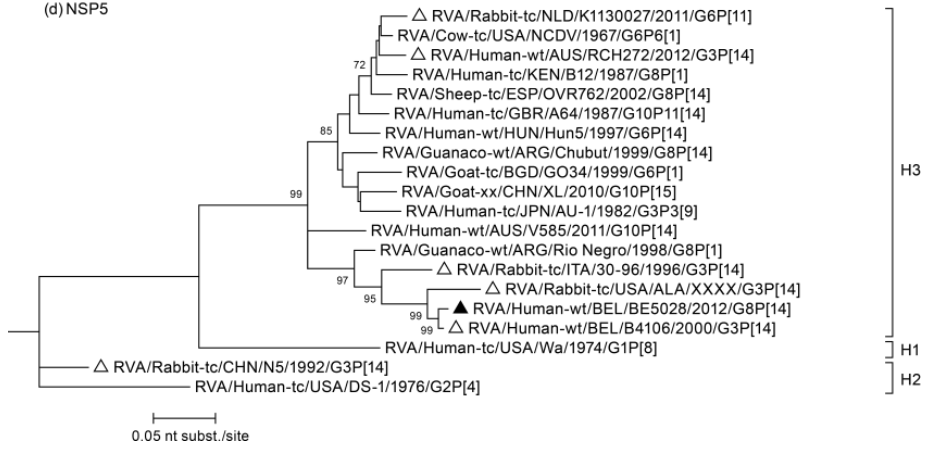
Figure 1. Phylogenetic trees of the BE5028 ( a ) VP7; ( b ) VP4; ( c ) NSP3 and ( d ) NSP5 genes. Bootstrap values (500 replicates) above 70 are shown. Strain BE5028 is indicated by a black triangle, other lapine(-like) RVA strains are indicated with a white